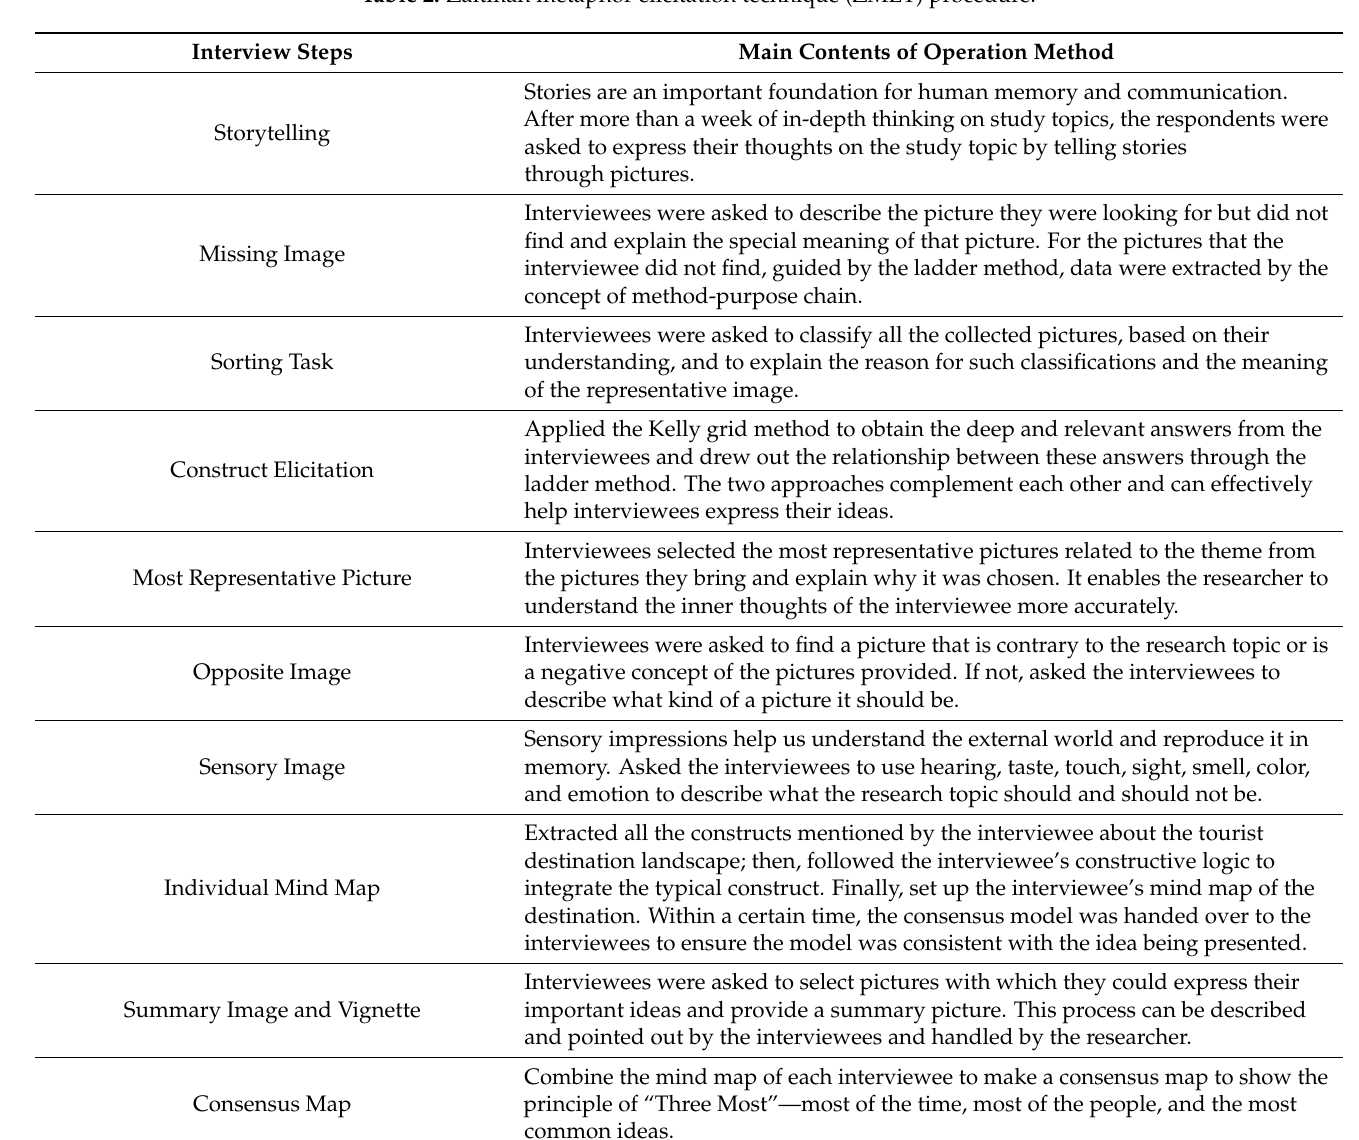
Table 2. Zaltman metaphor elicitation technique (ZMET)